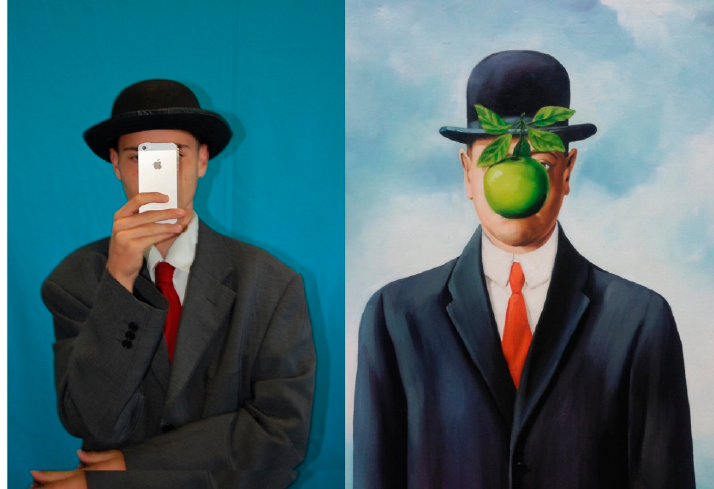
Figure 1. Example of a student in the process of enacting Le Fils de l’Homme (René Magritte, 1964).